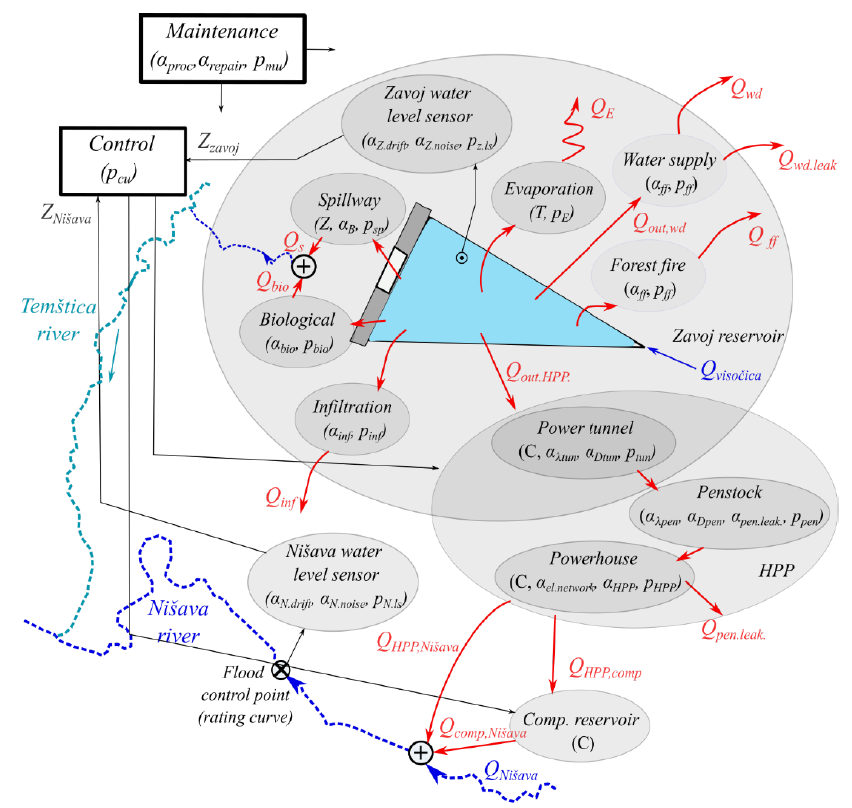
Figure 5. Conceptualization of the decomposed Pirot DRS with interdependency links between sub-